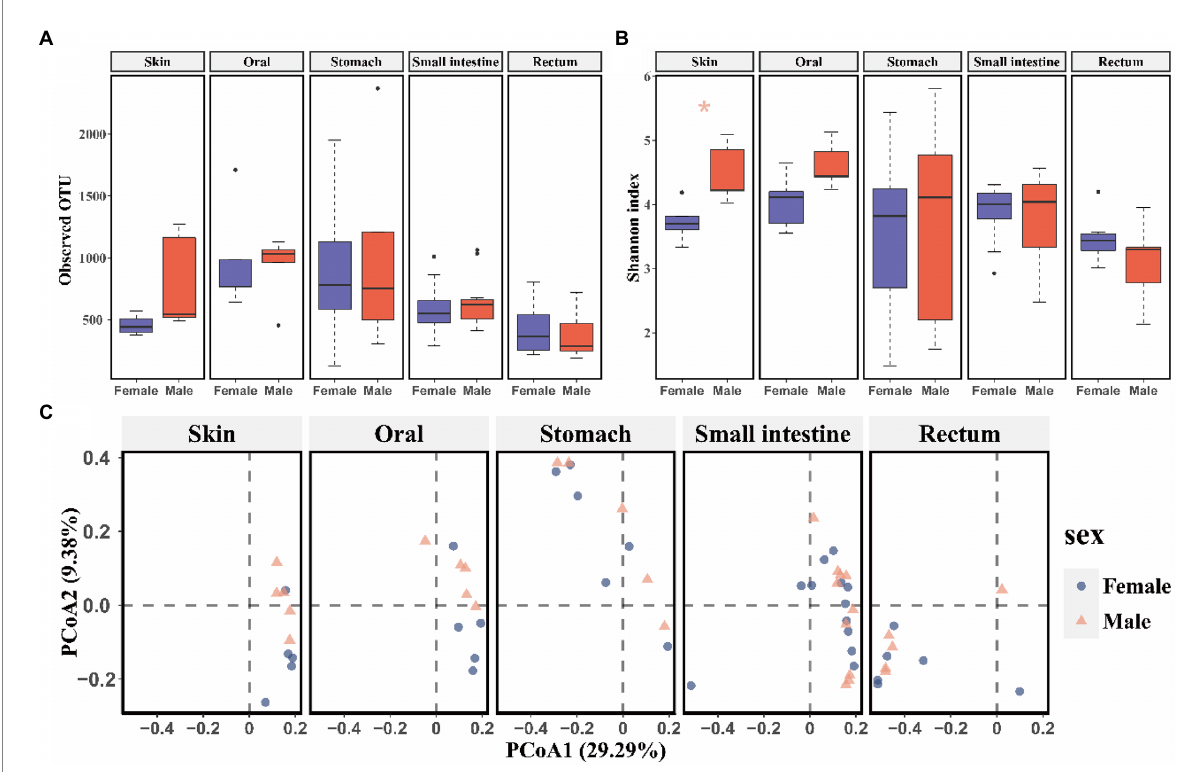
FIGURE 1 The comparison of alpha and beta diversity of symbiotic microbiota between released female and male CGSs. (A) Boxplot of observed OTU values; (B) Boxplot of Shannon diversity values. Data are presented as means ± SE, and significant differences are marked with an asterisk; (C) PCoA scatter plots present the dissimilarity of microbiomes at the OTU level based on Bray-Curtis